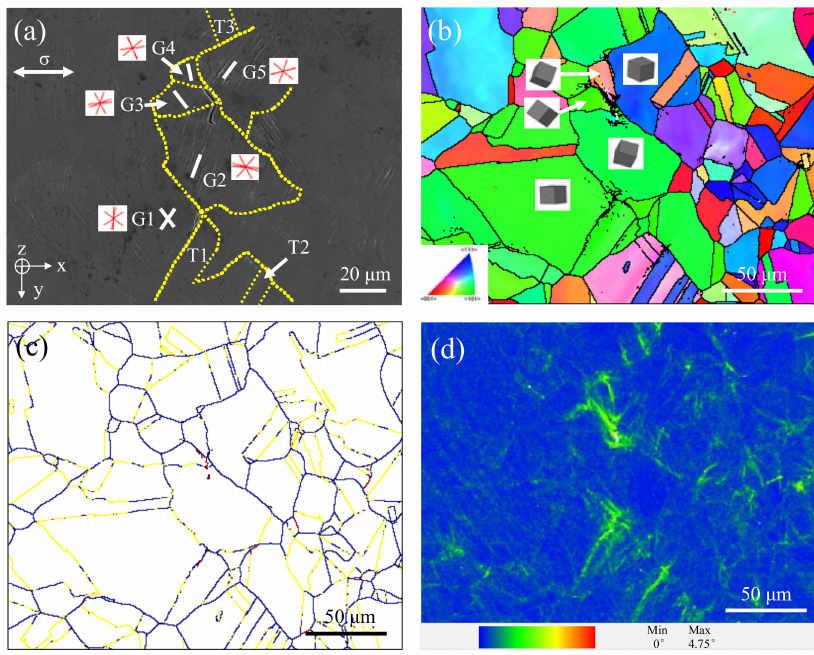
Figure 9. Crystal orientation maps with two small fatigue cracks at 332 MPa: ( a ) SEM image, ( b ) IPF (inverse pole figure) image, ( c ) grain boundaries image (HAGBs (high angle grain boundaries) in blue line, LAGBs (low angle grain boundaries) in purple line, Σ 3 twin boundaries in yellow line), and ( d ) LM (local misorientation)